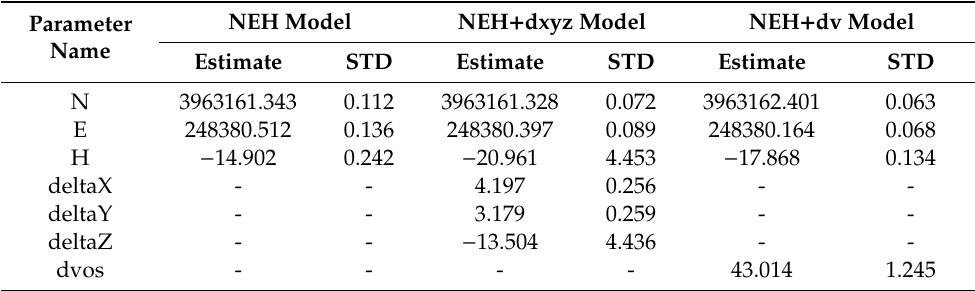
Table 1. Results of Three Estimation Model (Unit: m. NEH represent the coordinate components of the transponder position in the northing, easting, and height directions, including N, E, and H; dxyz means three components of transceiver lever arms in the ship-fixed coordinate system, including deltaX, deltaY, and deltaZ; dv indicates the velocity of sound, dvos; STD means the standard deviation of the